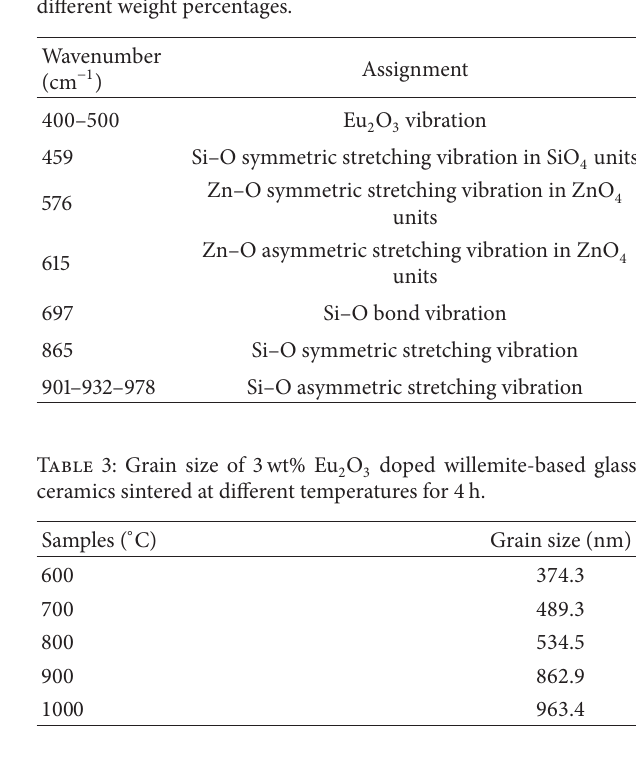
Table 2: FTIR transmission features and respective assignment O doped willemite sintered at various temperatures and for Eu 2 3 different weight percentages.